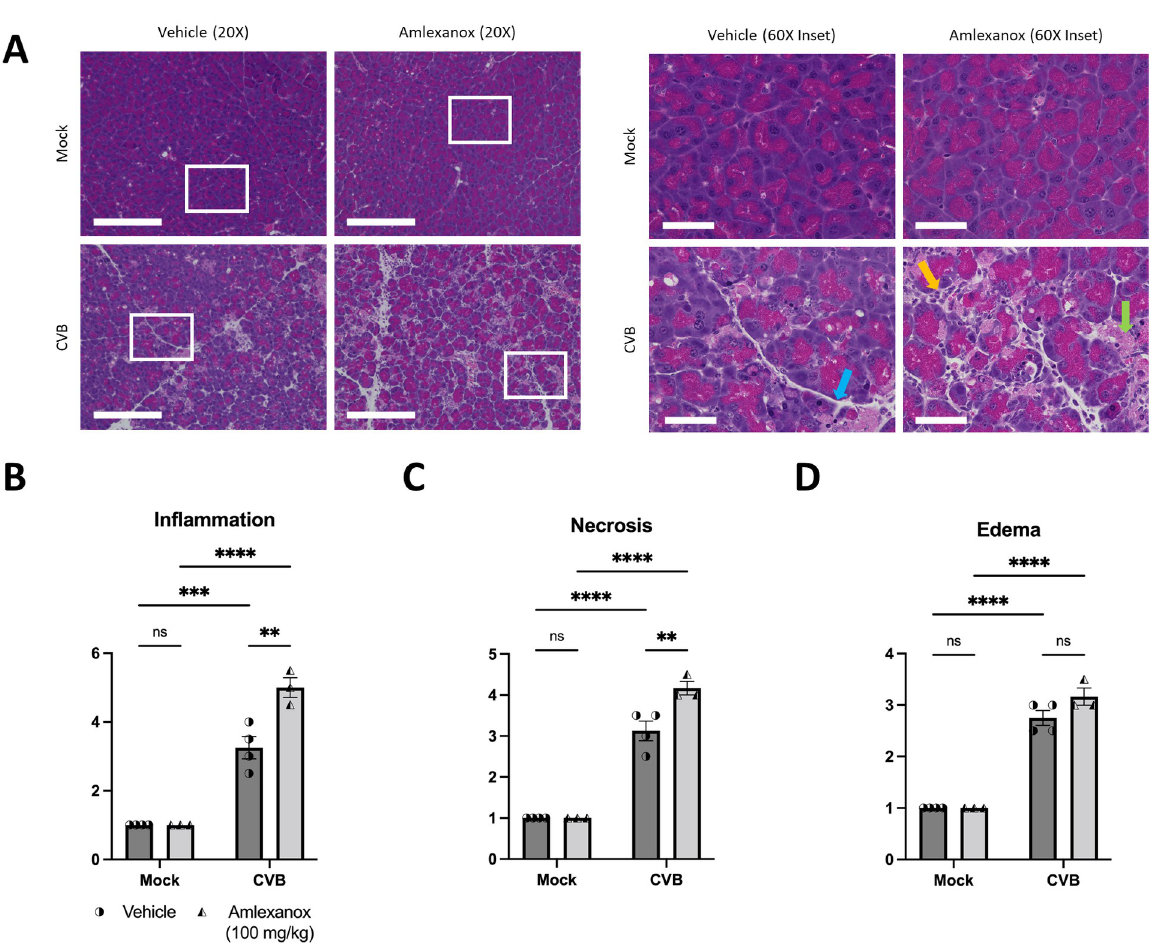
Fig 9. In vivo Amlexanox treatment increases pancreatic tissue destruction in CVB-infected mice. Ten-week-old C75BL/6 male mice were treated with 100 mg/kg Amlexanox or equal volume vehicle for 5 days pre-infection and each day following infection via oral gavage. On the fifth day of Amlexanox treatment, mice were infected I.P. with 10 7 plaque forming units (PFU) eGFP-CVB. (A) Hematoxylin and eosin staining on representative pancreas sections. Scale bars represent 50 μ m. (B) Quantification of inflammation (yellow arrow) in mock-infected versus CVB- infected pancreata with or without Amelxanox treatment. (C) Quantification of necrosis (green arrow) in mock-infected versus CVB-infected pancreata with or without Amelxanox treatment. (D) Quantification of edema (blue arrow) in mock-infected versus CVB-infected pancreata with or without Amelxanox treatment. All tissue sections were scored blindly. �� , p < 0.01, ��� , p < 0.001, ���� , p < 0.0001, two-way ANOVA; n = 3–4. Data are representative of 3